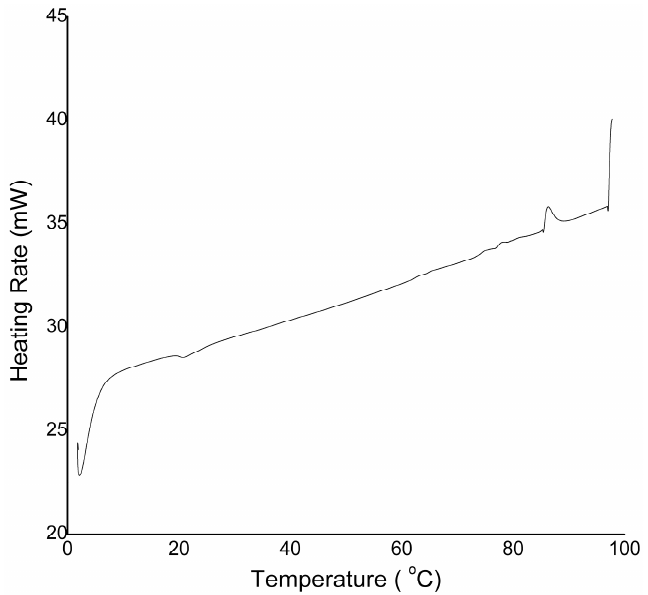
Figure 4. Differential scanning calorimetry (DSC) analysis chart of ALDC immobilized on alginate/gelatin beads.